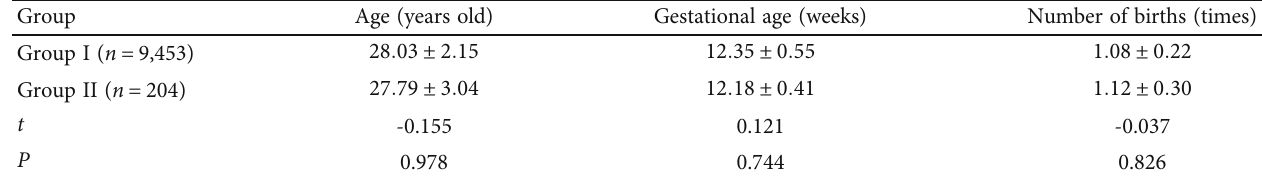
Table 2: Comparison of basic data between the two groups of pregnant